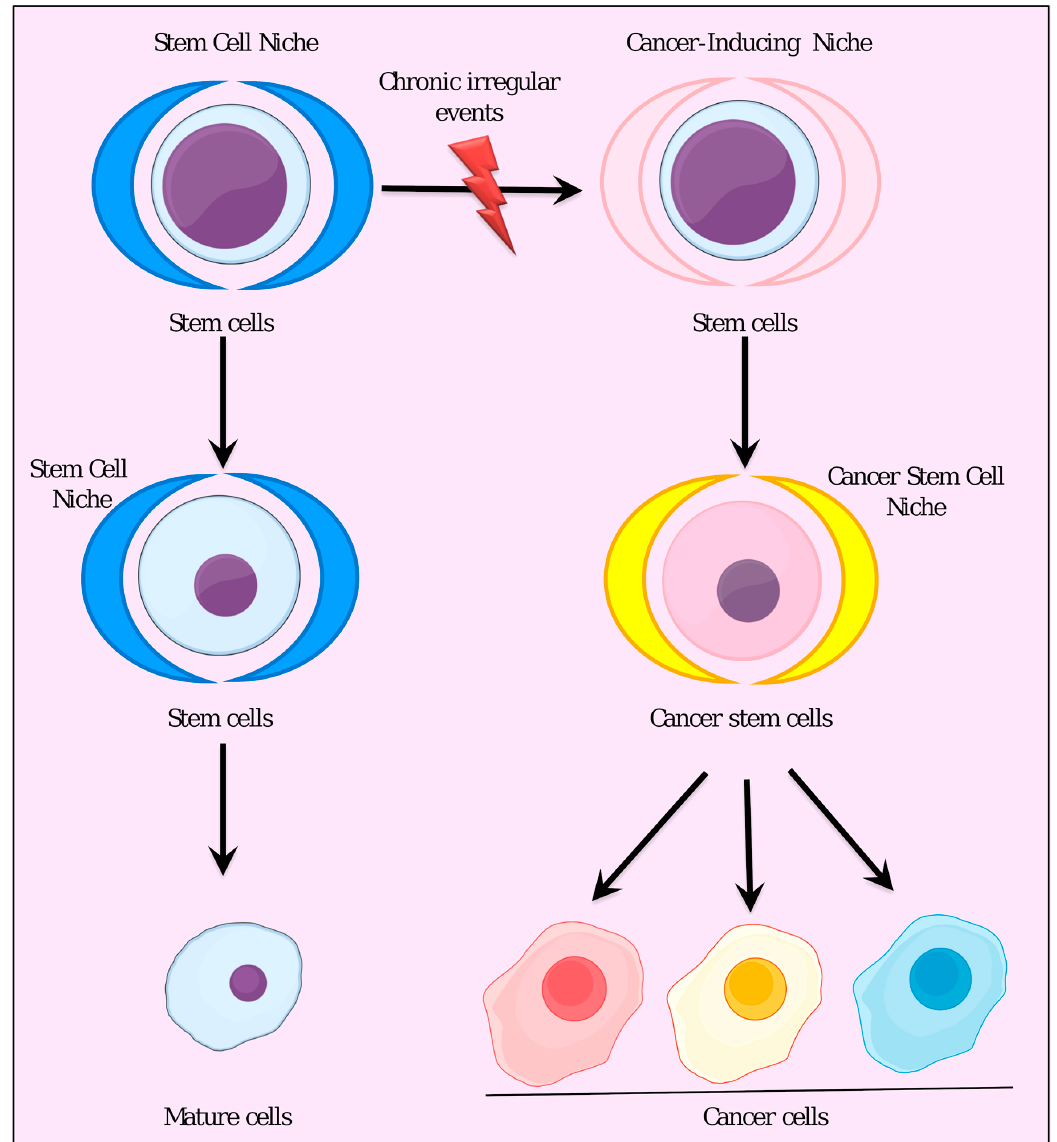
Figure 4. Stem cell differentiation in the stem cell niche and cancer-inducing niche.